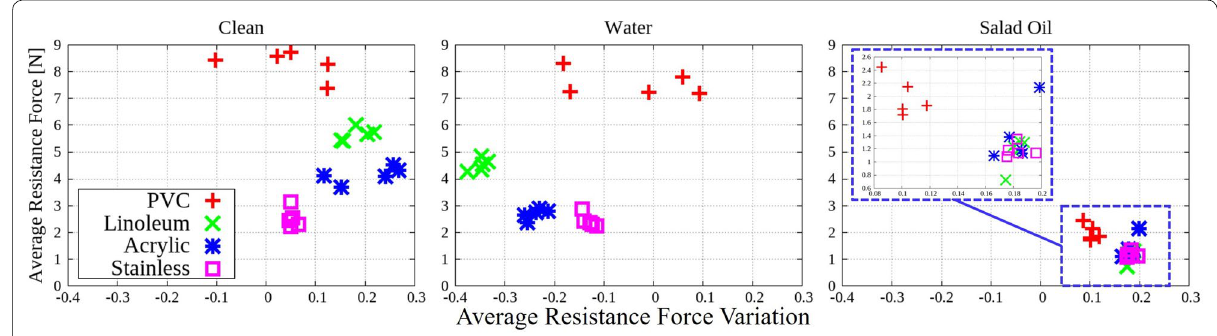
Fig. 12 Variation and value of the resistance